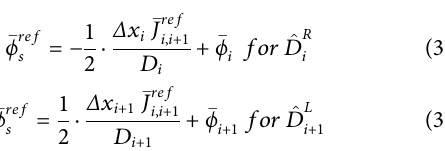
Frontiers in Energy Research |